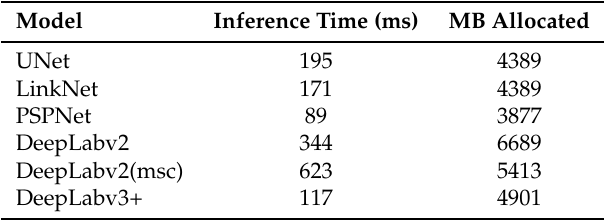
Table 5. Comparison of segmentation models in terms of inference